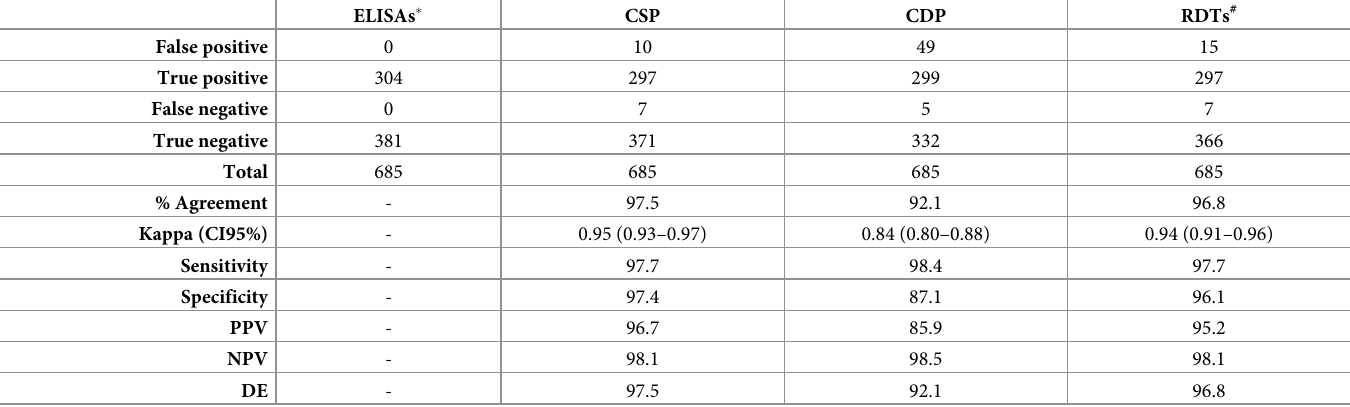
Table 3. Table comparing the results of Chagas Stat Pack (CSP) and Chagas Detect Plus (CDP) individually or taking into consideration their combined use (RDTs) versus the "gold-standard" based on